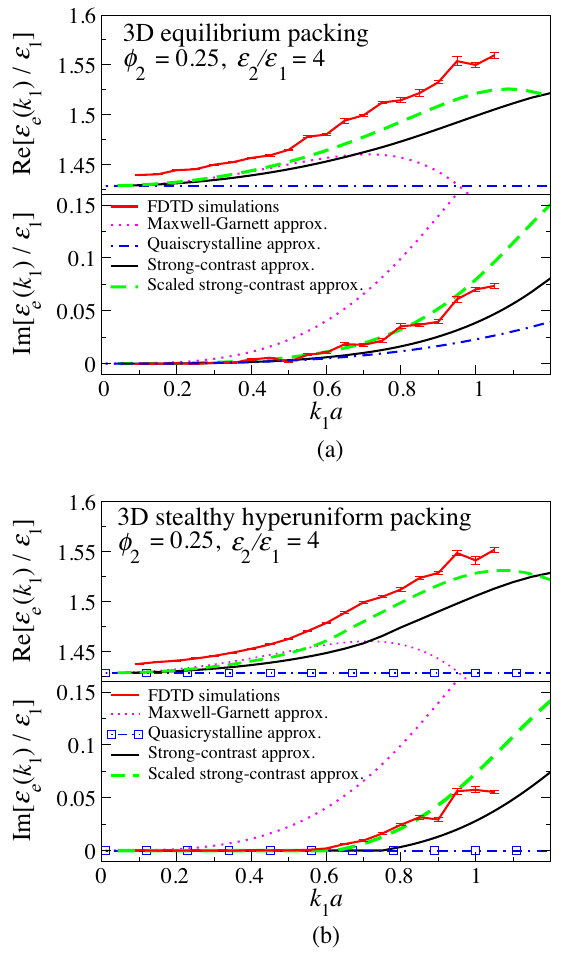
FIG. 9. Comparison of the predictions of the strong-contrast formulas Eqs. (67) and (73) to the MGA (16) and QCA (18) approximations for the effective dynamic dielectric constant ε k 1 Þ as a function of the dimensionless wave number k 1 a e ð of 3D disordered sphere packings to our corresponding